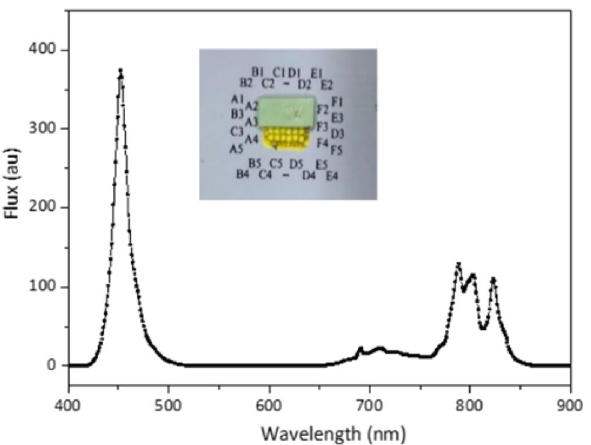
Figure 14. The measured spectrum by turning on the LED dies in the second row, which was covered with the IR phosphor.